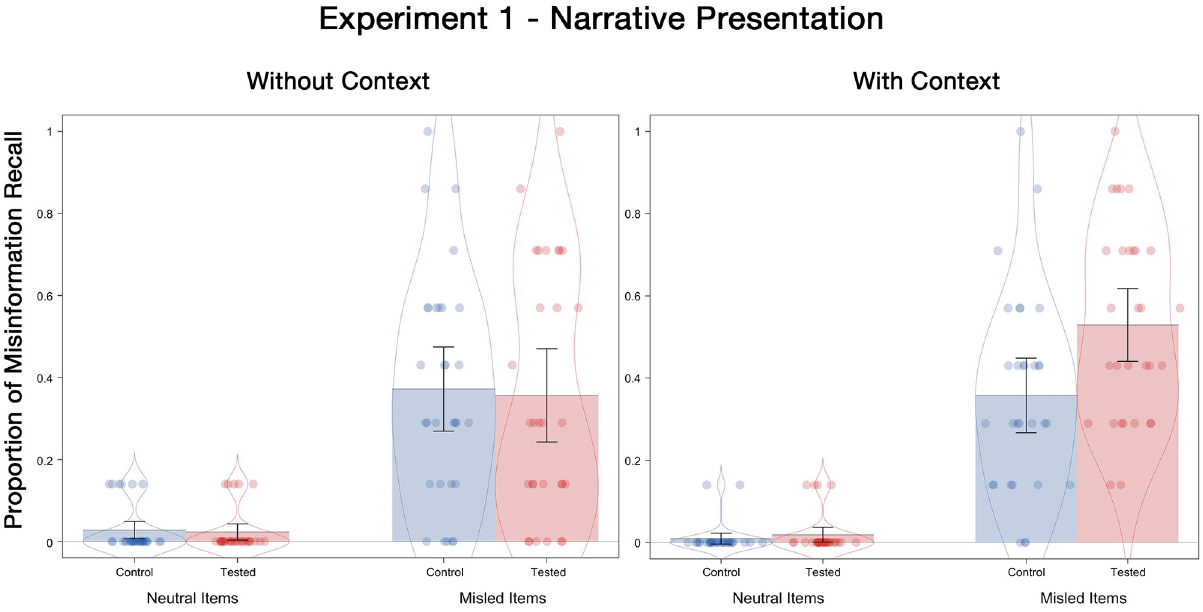
Fig 2. Misinformation recall probabilities for neutral and misled items as a function of the presence and absence of contextual details on the final test of Experiment 1. Error bars indicate descriptive 95% confidence intervals.